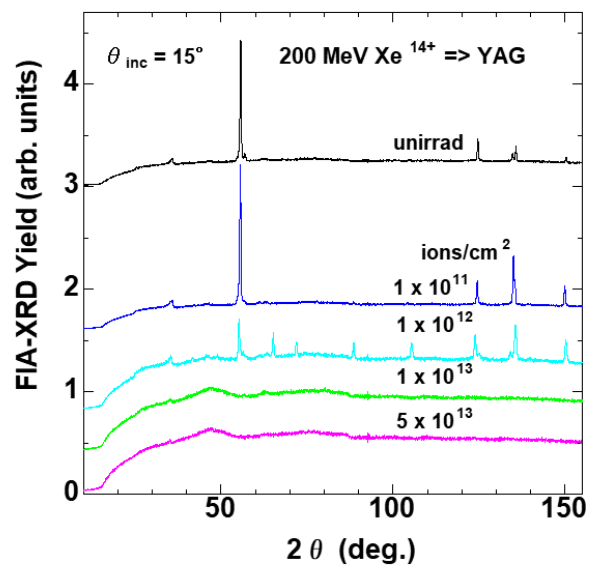
Figure 4. FIA-XRD patterns of undoped YAG samples in unirradiated state and irradiated with 200 MeV Xe 14+ ions to various fluences ranging from 1 × 10 11 to 5 × 10 13 ions/cm 2 . The patterns are shifted for vertical direction for clarity.